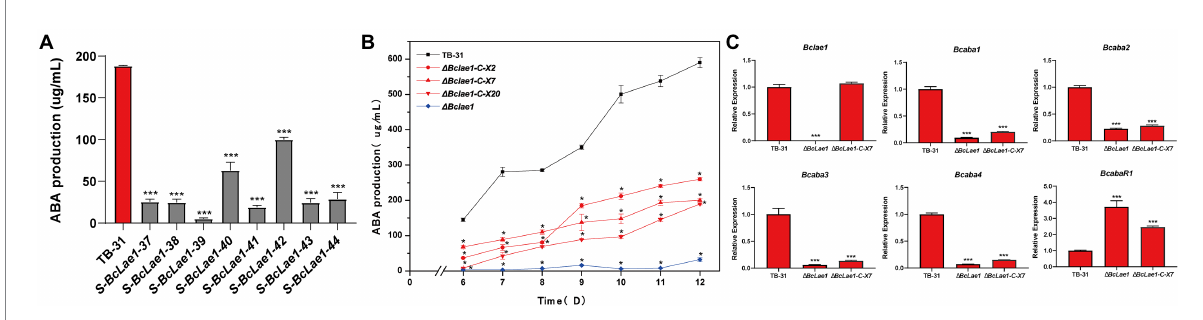
FIGURE 1 Deletion of Bclae1 affects ABA synthesis. (A) Eight Bclae1 gene silencing strains were randomly selected to grow on PDA. Samples for the quantitative determination of ABA production were collected at day 7. The error bars indicate the standard errors of the mean (SEM) for three replicate cultures ( n = 3). Asterisks indicate significant differences in ABA production between selected silencing mutants and TB-31 ( p < 0.001). (B) The Δ Bclae1 mutant and three randomly selected Δ Bclae1 -C mutants ( Δ Bclae1 -C-X2, Δ Bclae1 -C-X7, Δ Bclae1 -C-X20) were grown on PDA. Samples for the quantitative determination of ABA production were collected at 6–12 days. The error bars indicate the standard errors of the mean for three replicate cultures ( n = 3). Asterisks indicate significant differences in ABA production between selected mutants and TB-31 ( p < 0.05). (C) RT-qPCR examining the transcriptional levels of ABA gene cluster, BcabaR1 and Bclae1 in Δ Bclae1 mutant, Δ Bclae1 -C-X7, and TB-31. The relative transcriptional levels of selected genes were obtained after normalization to the constitutive tubulin reference gene (BC1G_05600) at 6 days. The relative values for selected genes transcription at 6 days in TB-31 were arbitrarily assigned as 100%. Shown are means and SEM, n = 3 independent biological replicates. *** p < 0.001 versus the same genes of the TB-31 group.